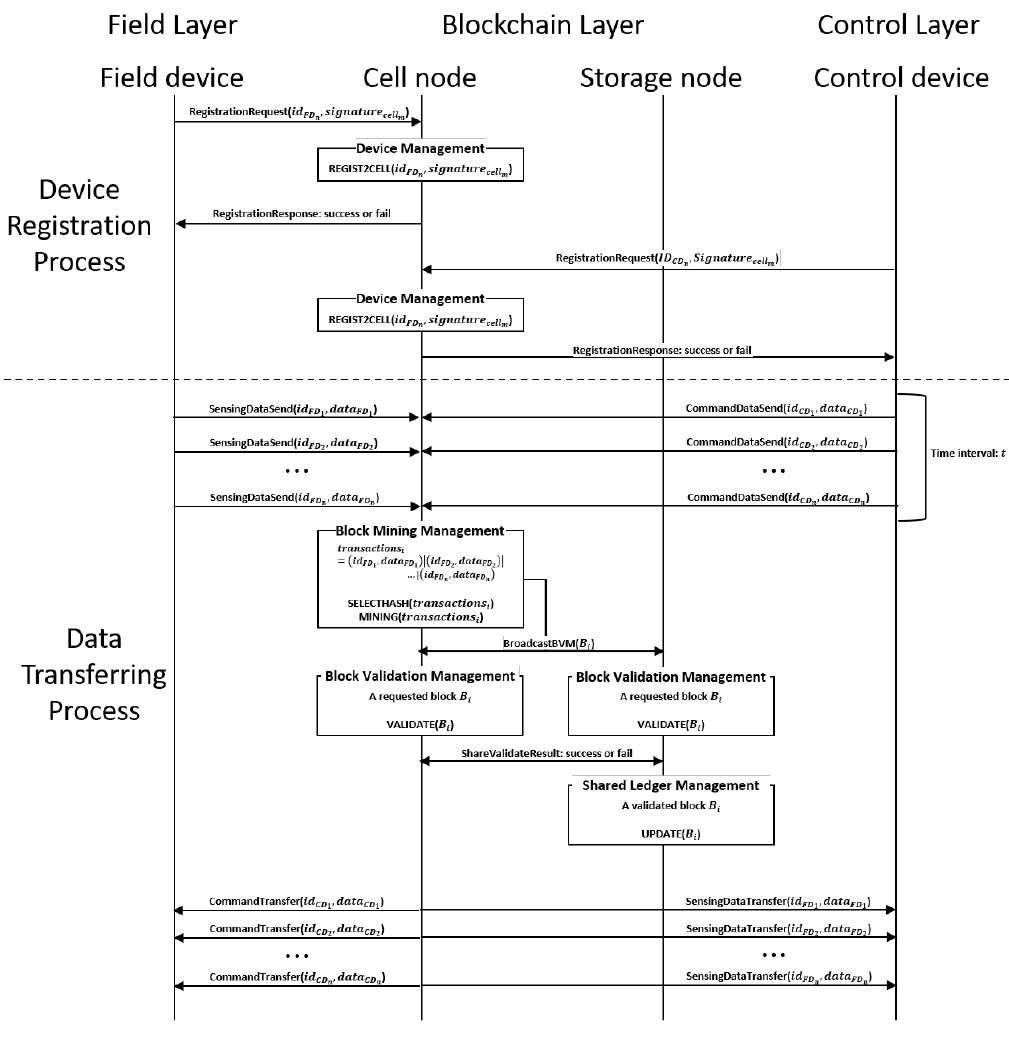
Figure 3. Proposed architecture interaction